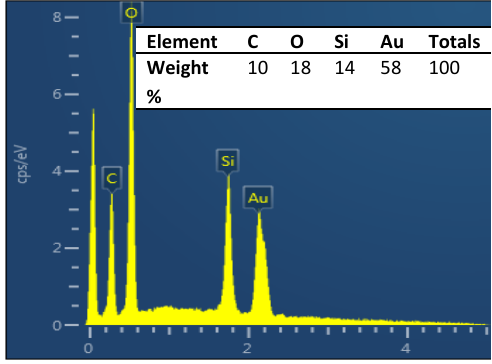
Figure 8. EDS mapping dots and element weight of the N 2 plasma treated sample.